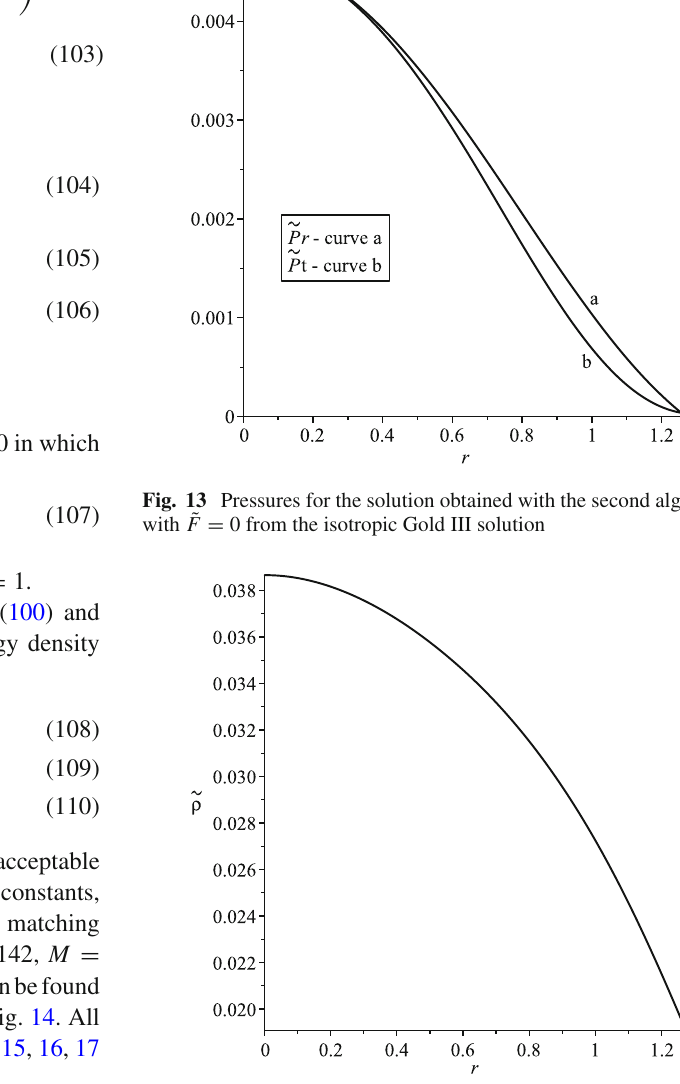
Fig. 14 Energy density for the solution obtained with the second algo- rithm with ˜ F = 0 from the isotropic Gold III